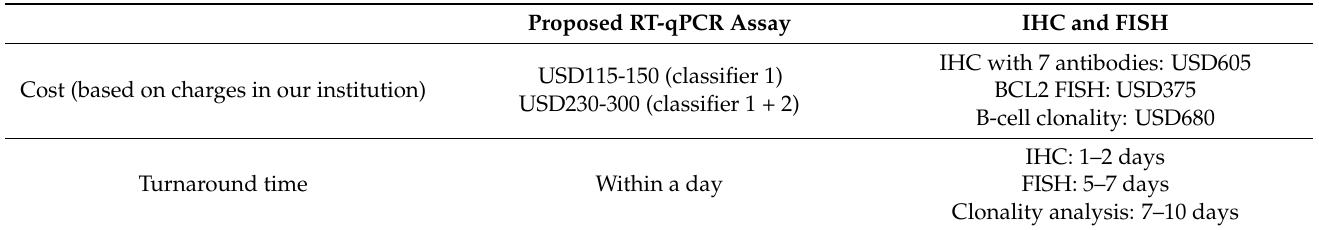
Table 2. Comparison between our proposed RT-qPCR assay and traditional IHC/FISH for small B-cell lymphoma